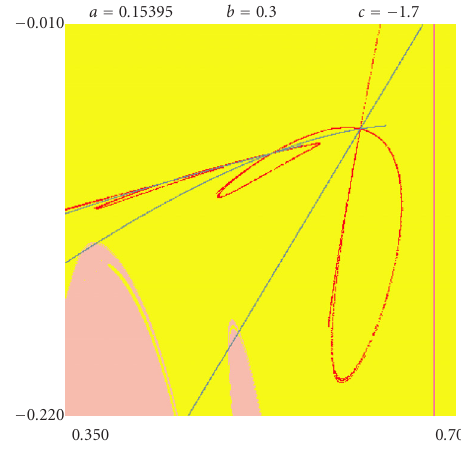
Figure 4.5. Contact between the focal point (and its images) and the attractor which becomes